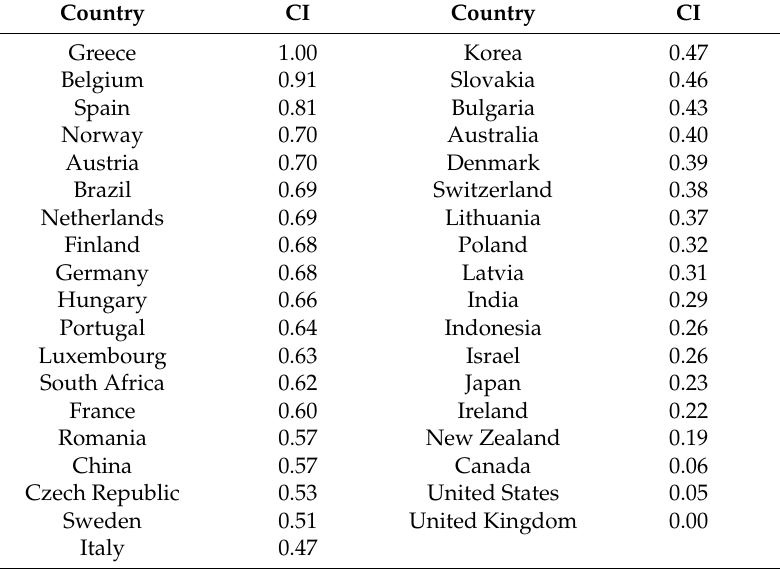
Table A1. The Coordination Index (CI) of the 37 Countries in the Database. Country CI